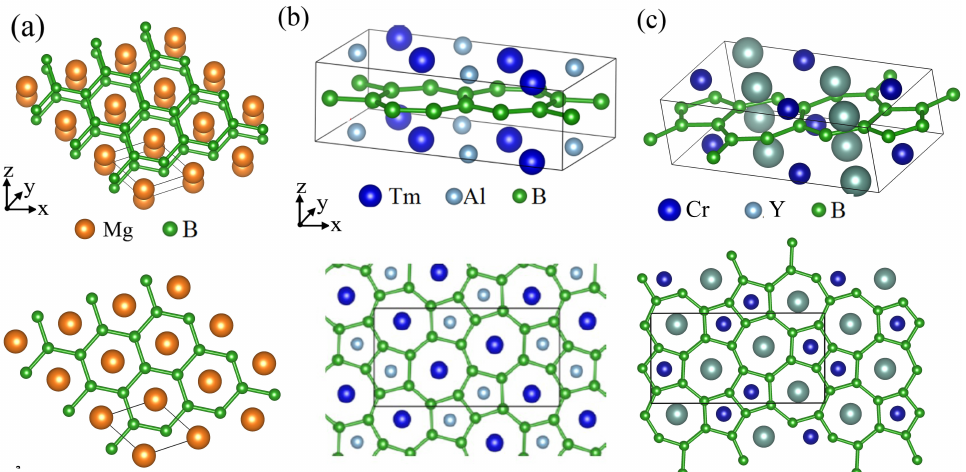
Figure 1. Crystal structures of metal-boron-layered materials. ( a ) Crystal structure of MgB 2 . ( b ) Crys- tal structure of TmAlB 4 . ( c ) Crystal structure of YCrB 4